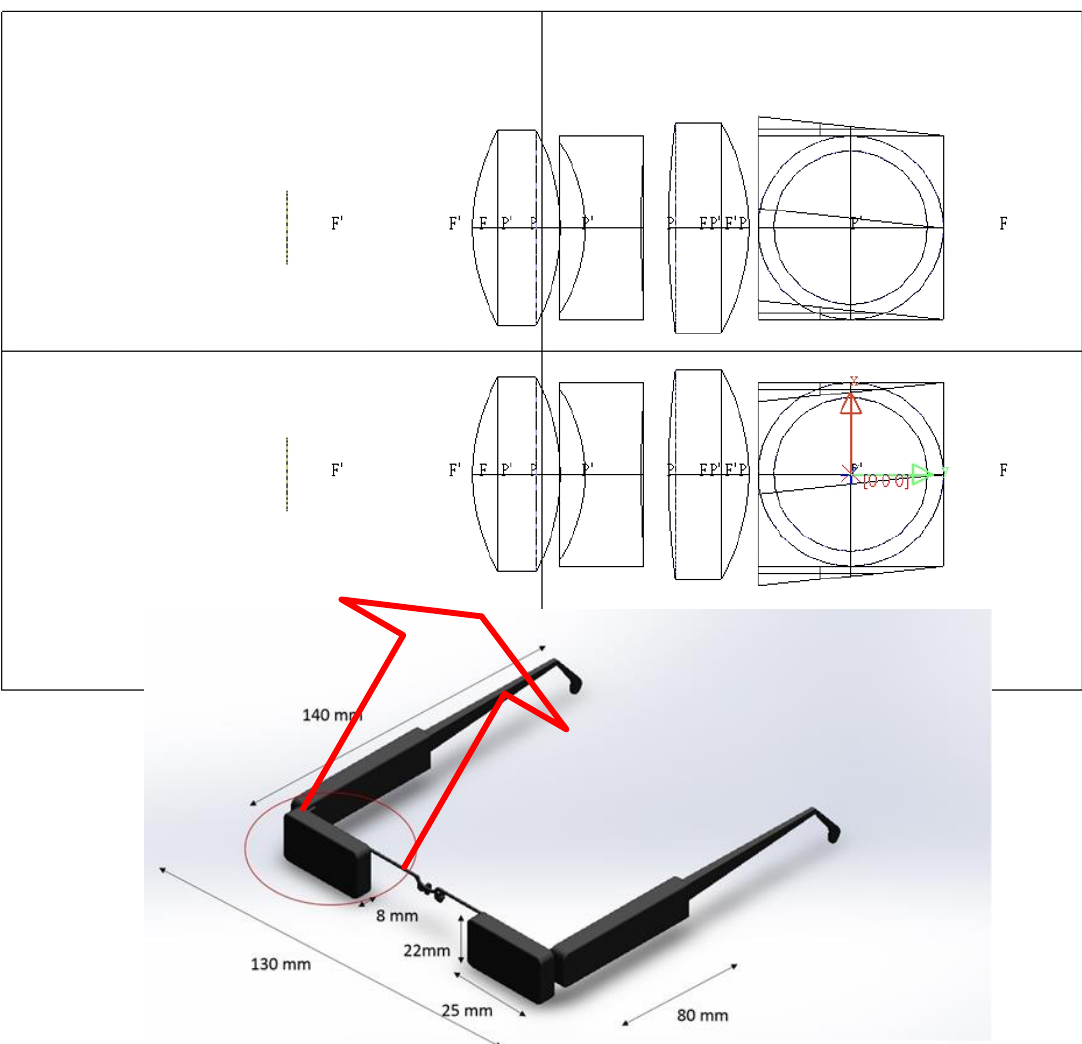
Figure 1. A conceptual design: the left diagram illustrates the detailed structure inside a single-glass frame of the right diagram; that is, a single 3D image-taking module.